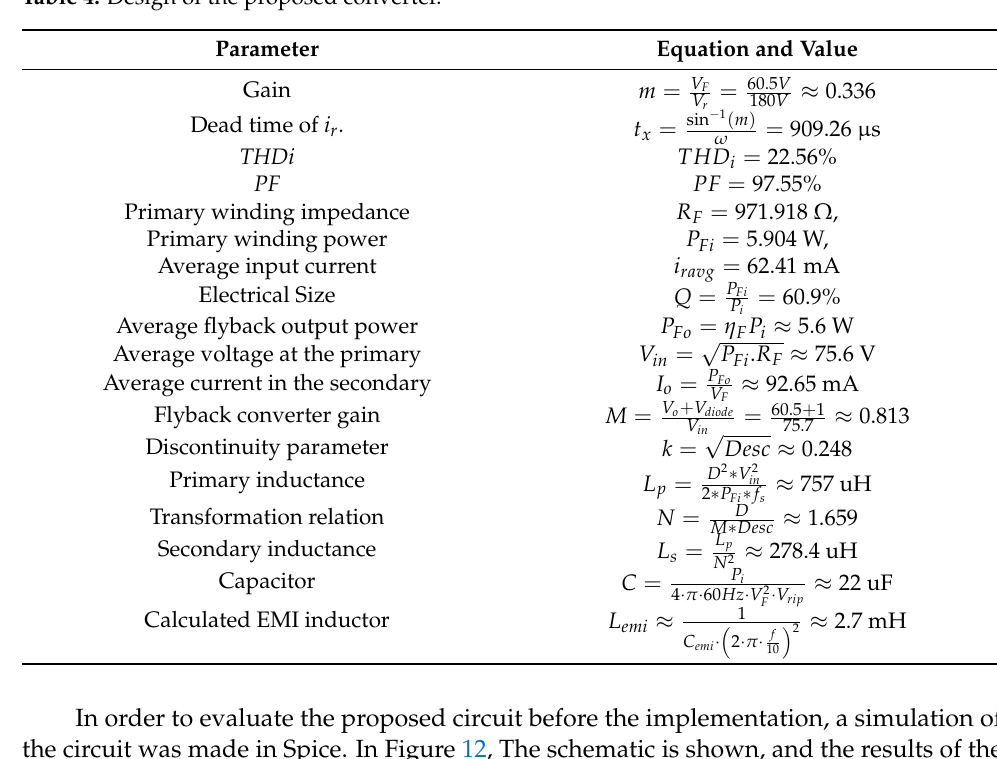
Table 4. Design of the proposed converter.